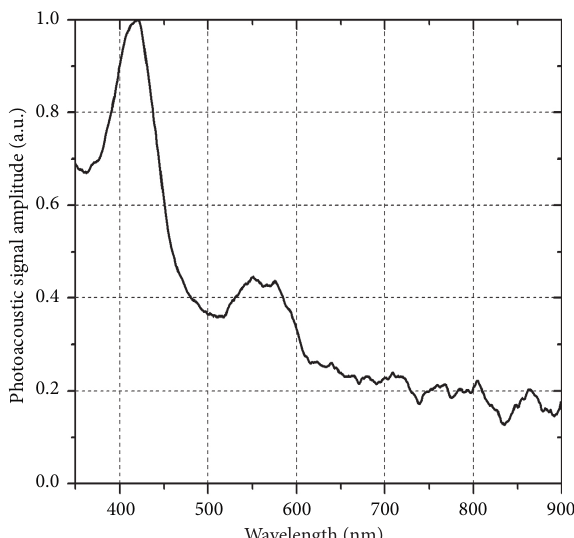
Figure 5: Absorbance measured in two cadaveric porcine trachea samples at different wavelengths.